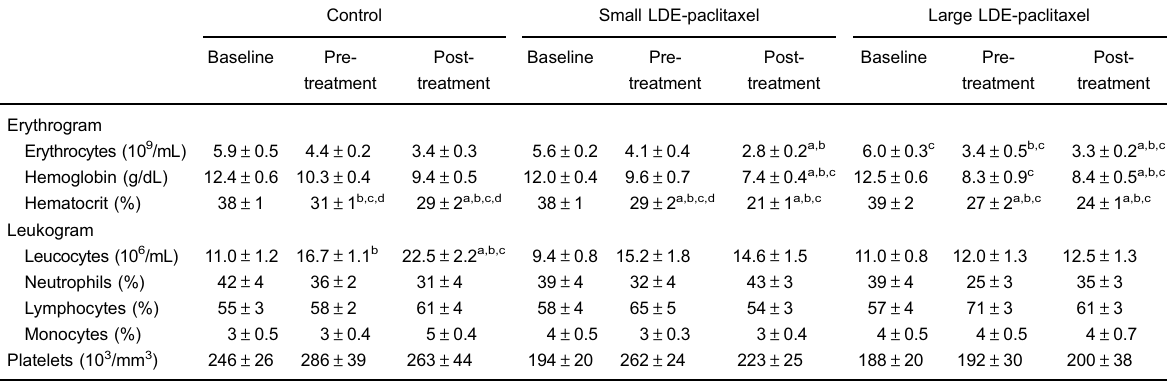
Table 2. Hematological pro fi le of rabbits from control group (n=9) and treated with small lipid nanoparticles (LDE)-paclitaxel (n=10) and large LDE-paclitaxel (n=9).